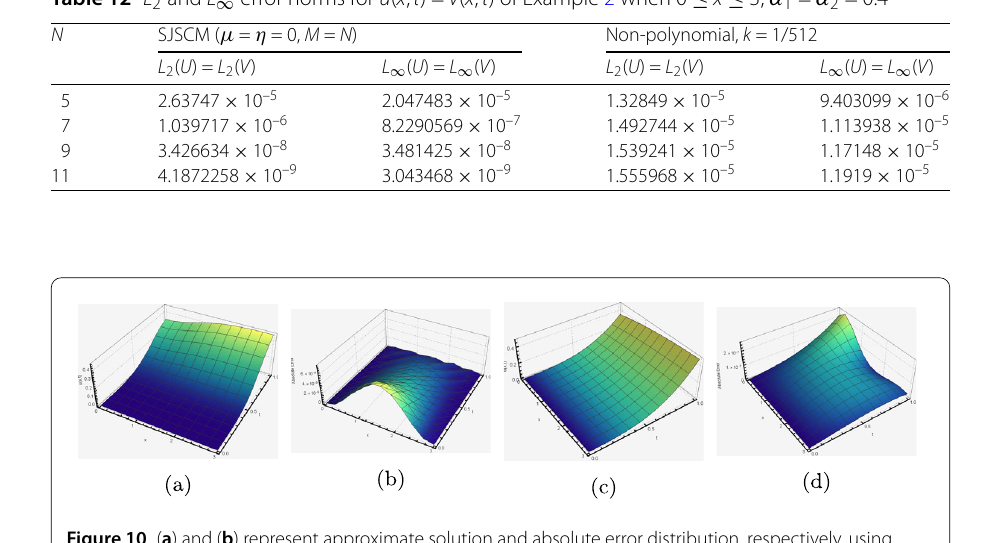
Figure 10 ( a ) and ( b ) represent approximate solution and absolute error distribution, respectively, using SJSCM. ( c ) and ( d ) represent approximate solution and absolute error distribution, respectively, using the